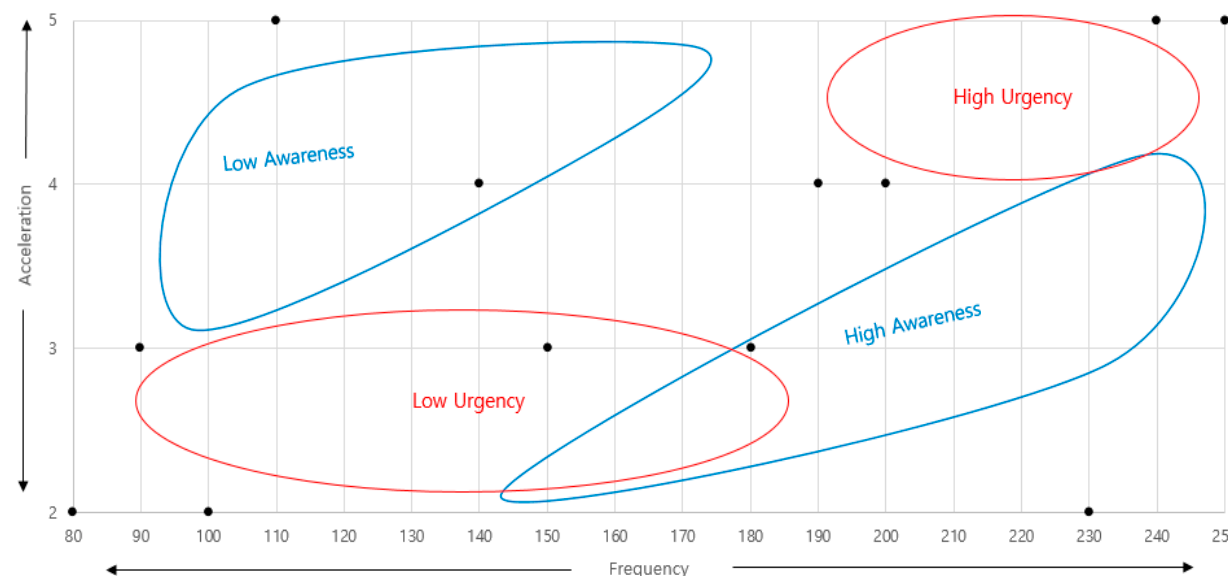
Figure 5. Emotional map of “frequency” and “acceleration”.